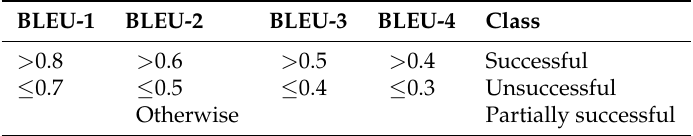
Table 1. Classification of generated captions based on the Bilingual Evaluation Understudy (BLEU)